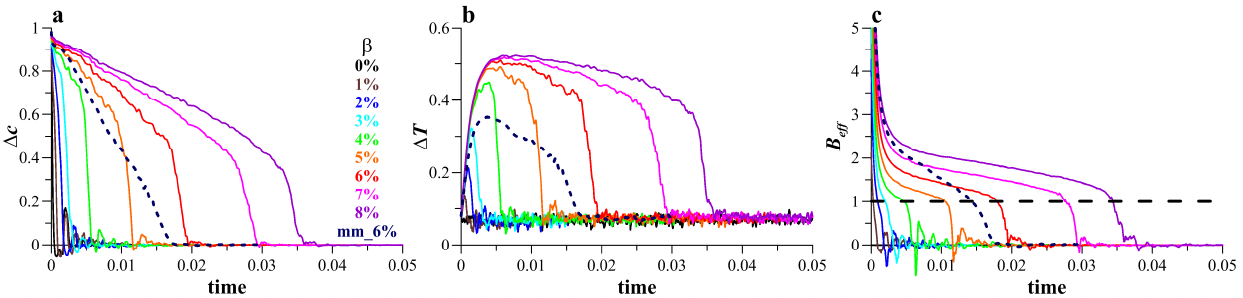
Figure 2. (a) The concentration, (b) the temperature differences between the lower and upper layers and (c) the effective buoyancy ratio as a function of time at different values of the initial compositional density contrast, β . Dashed blue line denotes the complex model (see in